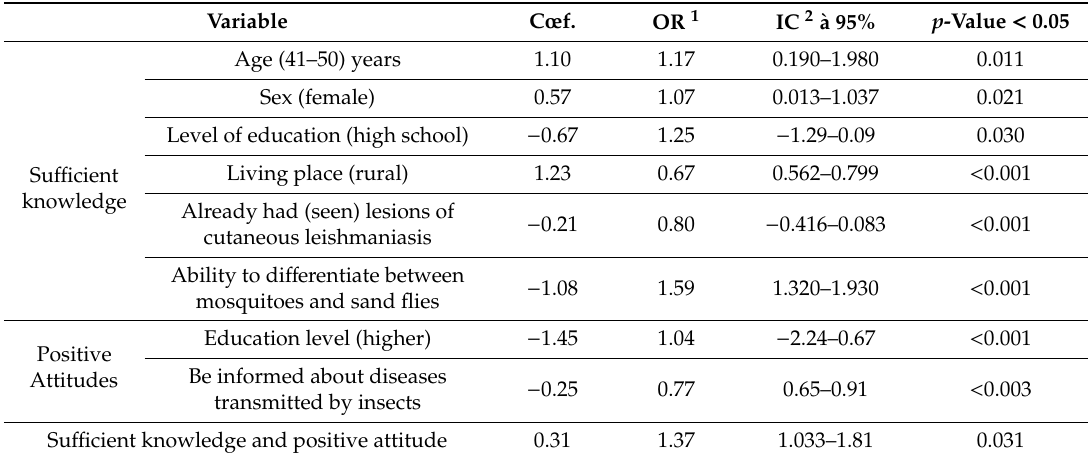
Table 5. Factors associated with high knowledge and positive attitudes in the local community about sand